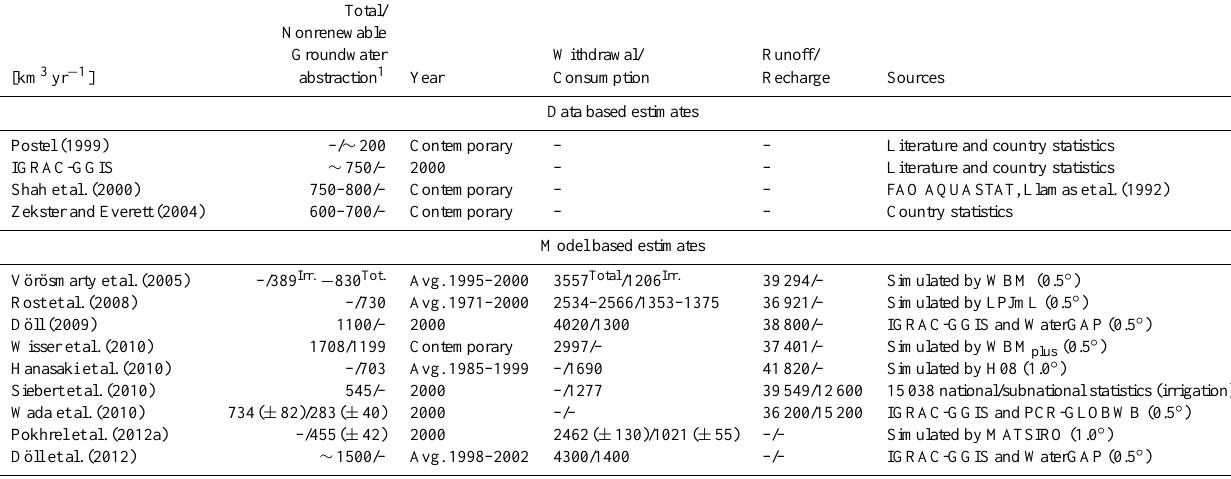
Table 6. Global estimates of groundwater